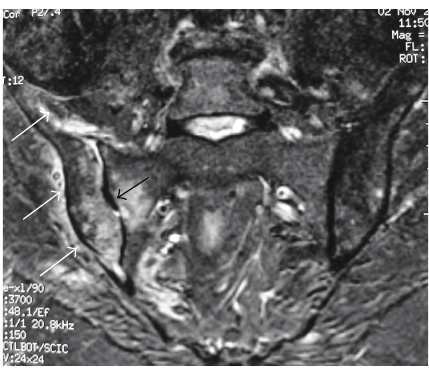
Figure 2: Coronal T2-weighted fat-suppressed MR image of the pelvis shows an increased signal intensity of the right sacroiliac joint (black arrow) and diffuse hyper intensity of the adjacent iliacus and gluteal muscles (white arrows).